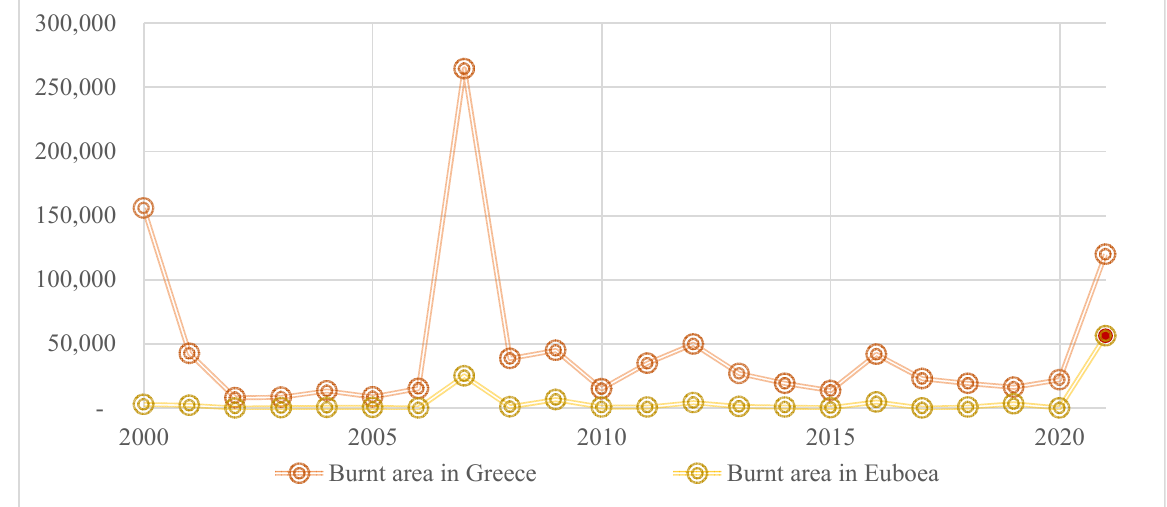
Figure 8. The evolution of wildfires in Greece and Euboea (2000–2021). Figure 9 summarizes the evolution of fire in Euboea 3–11 August 2021 (for a more detailed description, see also Section S2, Figures S7–S16, of supplementary material [74,75]). This event was covered by the largest media organizations worldwide (Figure S19). Even though the Euboea 2021 fire was highlighted as extreme, it is interesting to note that there were smaller but similar events in the area (in the same order of magnitude, i.e., more than 20,000 ha) in 1977 and 2007 (Figure S20). Annually burnt areas in Euboea are on average ~6 percent of the total burnt areas in Greece.